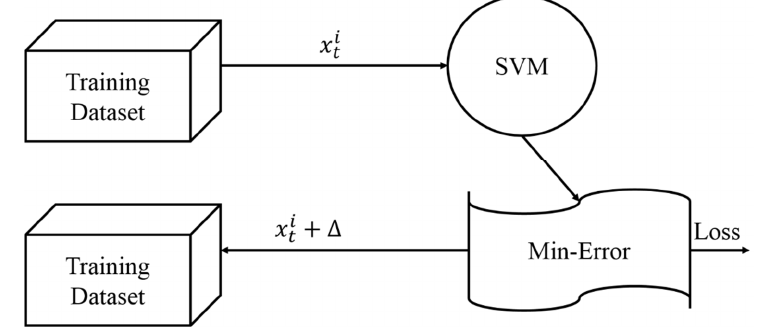
Figure 3. Training and testing architecture.